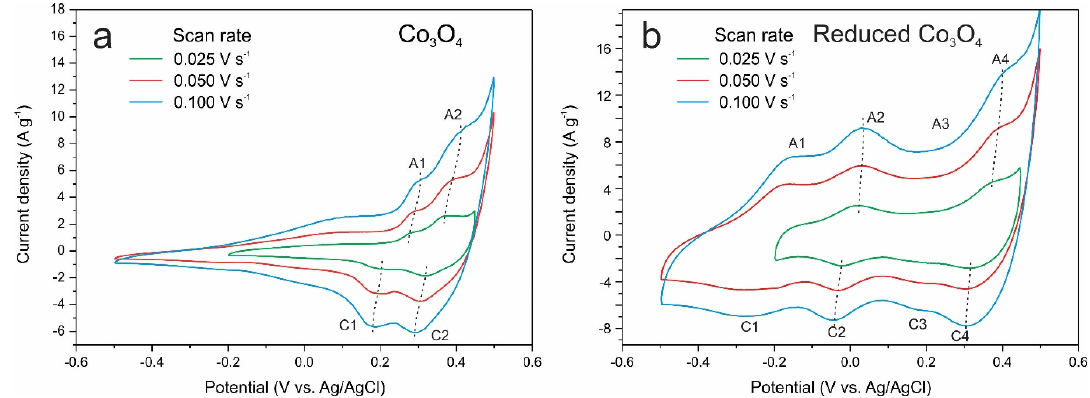
Figure 5. CV curves of Co 3 O 4 ( a ) and Re-Co 3 O 4 ( b ) samples at scan rates from 25 to 100 mV s −1 in a 3.5- M KOH aqueous solution.